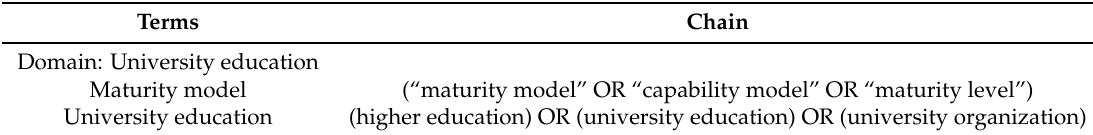
Table 1. Terms and logical connectors used in the search.